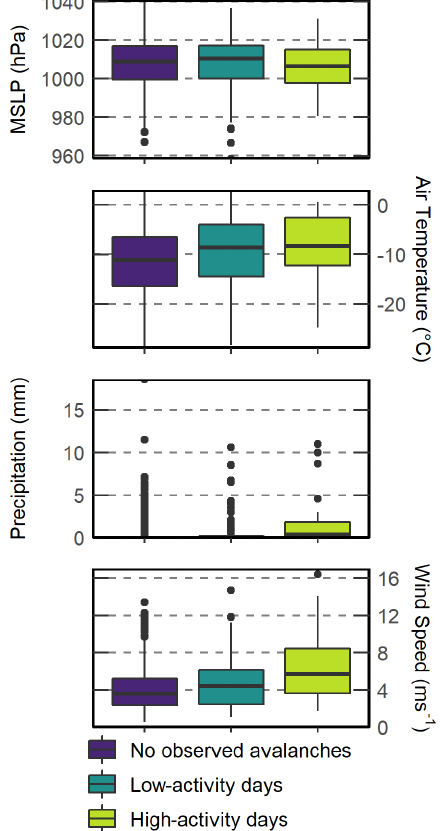
Figure 6. Boxplots showing the distributions for locally measured meteorological parameters by avalanche day type. Air temperature and wind speed are observed at the Gruvefjellet AWS, while pre- cipitation and MSLP are observed at the Svalbard Airport